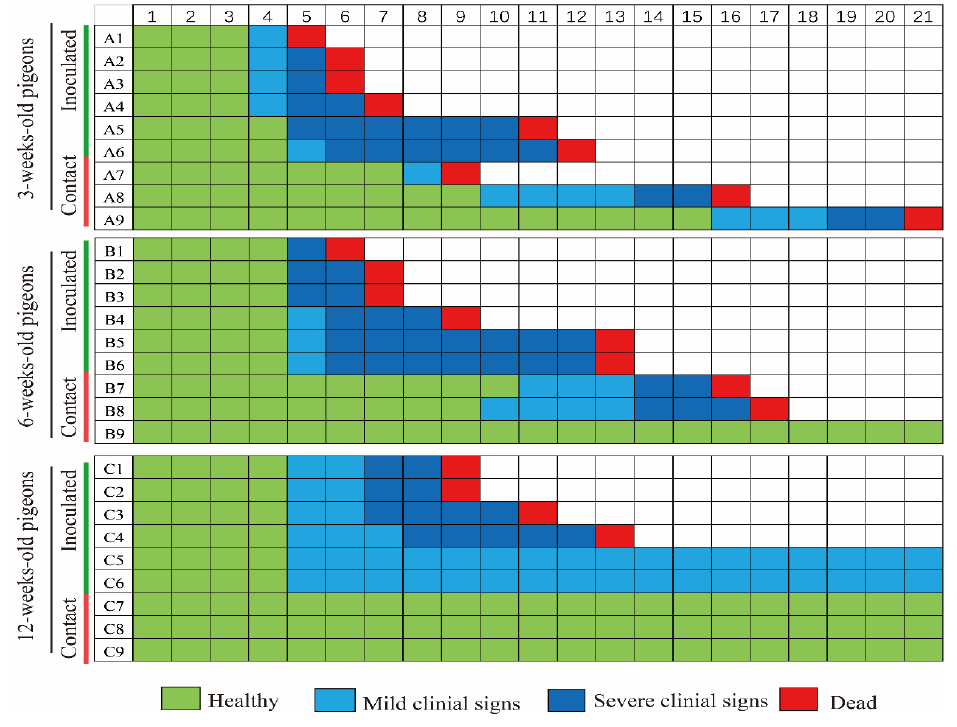
Figure 6. Clinical signs and lethality of the GZ08 virus in 3-, 6-, and 12-week-old pigeons. Clinical inspection was performed once daily, and symptoms were scored according to